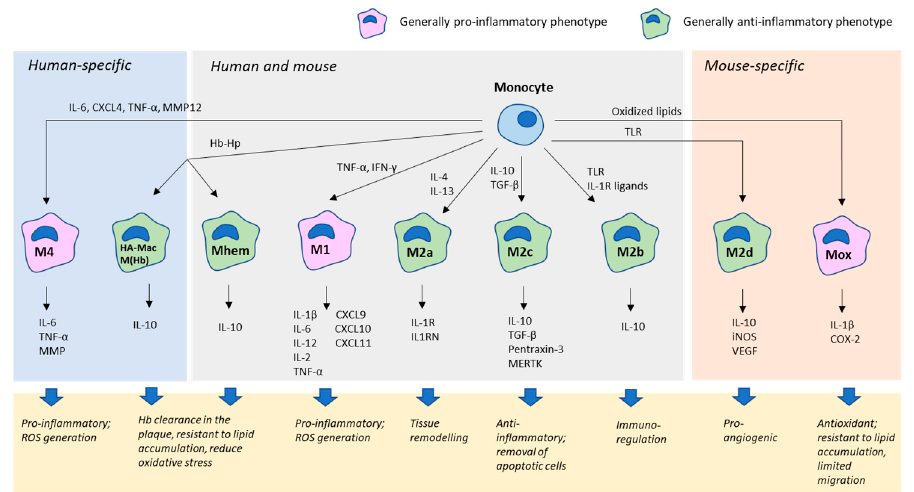
Figure 1. Macrophage diversity in the atherosclerotic plaque.